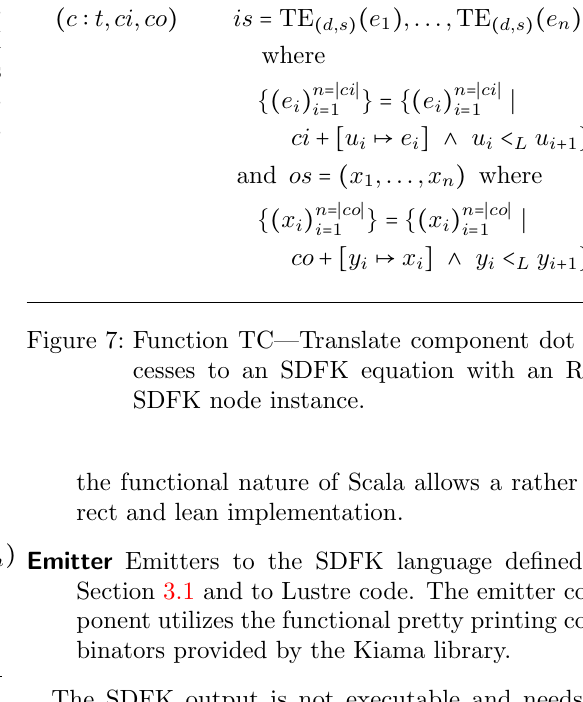
Figure 6: Function TE—Translate mACG-Modelica expression into SDFK expression